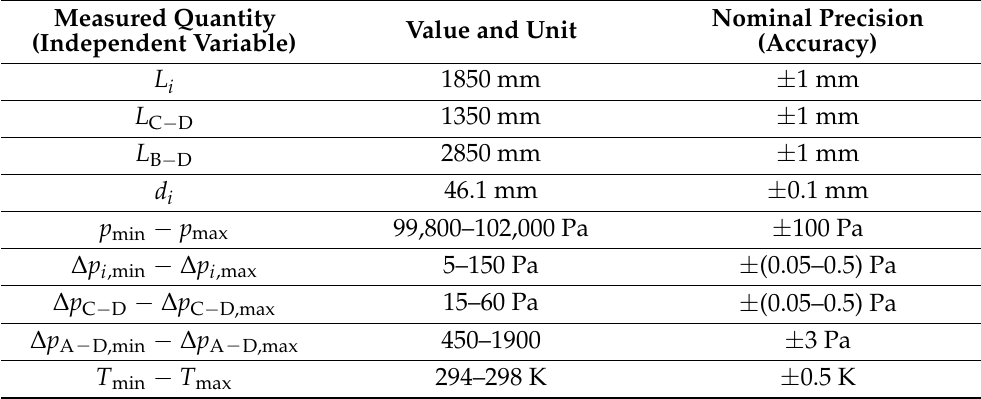
Table A1. Measured quantities and accuracy of the measuring devices